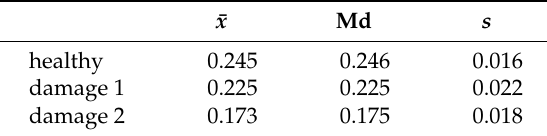
Table 4. Statistical data for all the scenarios at 10